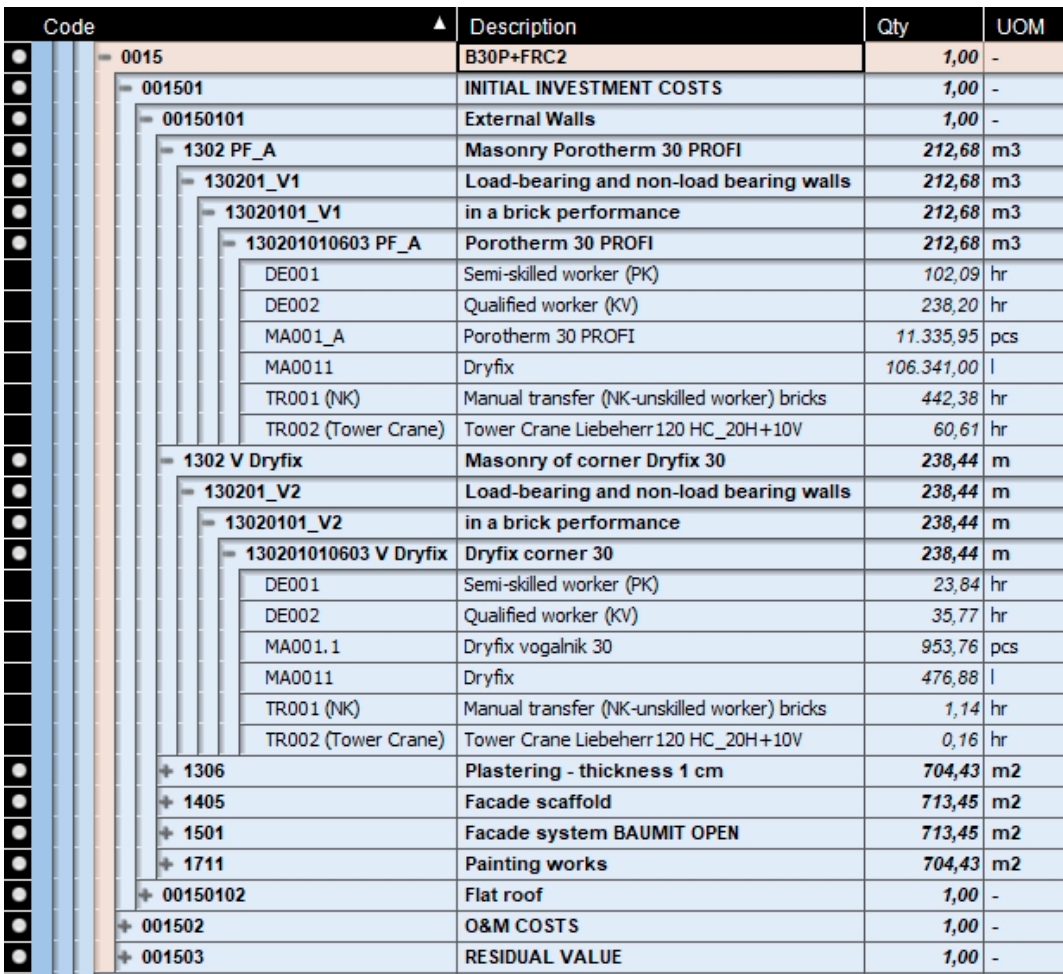
+ FRC2 at U 1 in VO